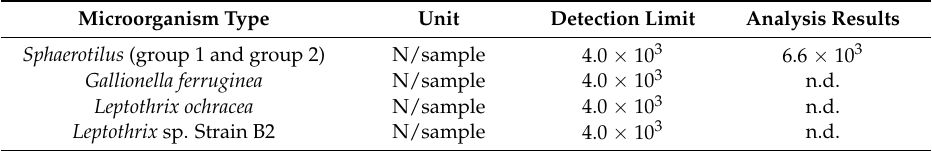
Table 2. Microbial investigation of the CIM filter top layer: detection limits and analysis results in number of cells per sample (N/sample, sample type: swab), based on the assumption that 1 DNA-copy is equal to 1 cell (n.d. = not